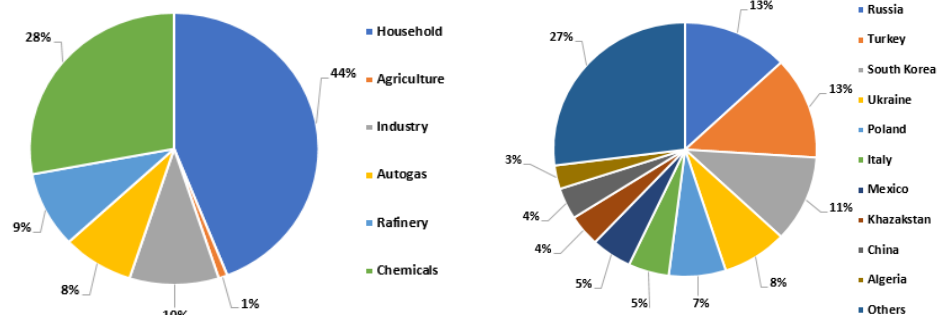
Figure 1. The share of Autogas in the total amount of LPG produced and the percentage of vehicles powered by this fuel in selected countries [2].